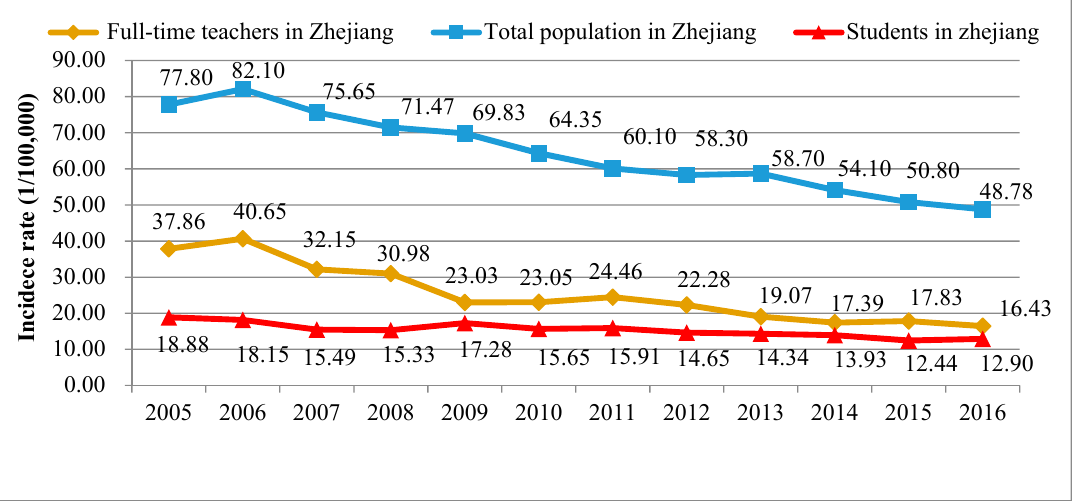
Figure 2. Pulmonary TB incidence rates among full-time teachers, students and the total population in Zhejiang.